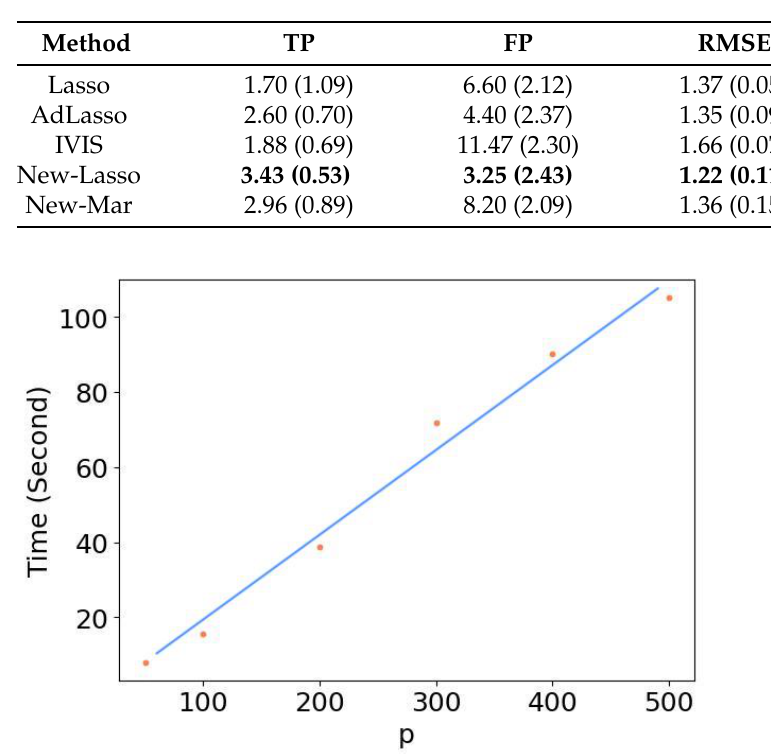
Figure A1. Simulation results: computation time of the proposed approach as a function of the number of features p for five replicates under Scenario 6 with N = 200, q = 20, ρ = 0.3. The red dots represents the computation time under corresponding variable dimension, and the blue line represents the fitted value.